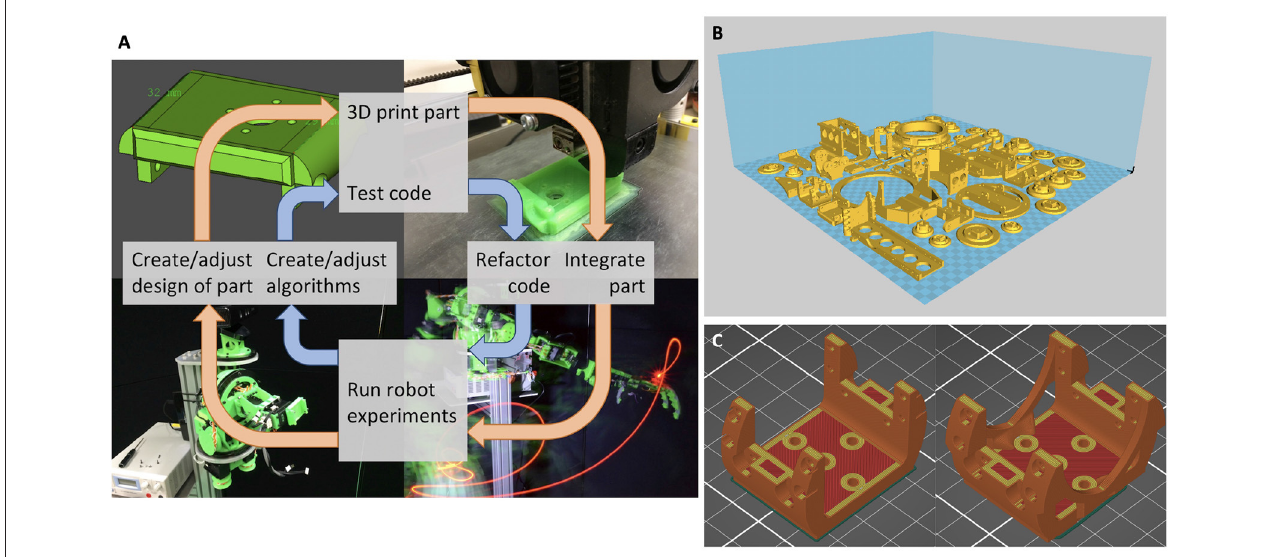
FIGURE 4 | In (A) : 3D-printable hardware enables fast iterative design of both “brain” and “body.” The diagram shows the concurrent design loop of software (blue inner arrows) and hardware (orange outer arrows) of the GummiArm project. One complete cycle can take as little as just a few minutes. In (B) : The printable parts of the GummiArm v1.0, on a hypothetical 500 mm by 500 mm printing surface. Most parts are printed with 20% infill, which means a total of 523 g of PLA plastic is required. This is equivalent to 175 m of a 1.75 mm filament, with a total cost of about $20. On an original Prusa i3 MK3 with a print bed of 250 x 210 mm the following printing times are estimated: 16 h for parts required for the lower shoulder, 34 h and 23 min for parts required for the upper shoulder, 13 h for parts required for the lower arm, 13 h and 40 min for parts required for the upper arm, which makes a total of 77 h and 10 min. This is using a PrusaSlicer 2.3.0 based on Slic3r, with a 0.4 mm nozzle, in simple mode, using the default print settings “0.15 mm QUALITY,” modified to a 20% infill. In (C) : Change to the shoulder encoder holder for the GummiArmCE. On the left is the original part designed for PLA, while on the right is the Nylon version. The volume increased around 25% from PLA (12,358 mm 3 ) to Nylon (15,437 mm 3 ) and the weight went from 15.32 to 18.53 g, respectively. Sliced using PrusaSlicer 2.3.0 with 0.15 mm layer height, first layer 0.2 mm, minimum 5 vertical shells, minimum 7 top and 5 bottom solid layers, and 100% infill due to the high loading of the